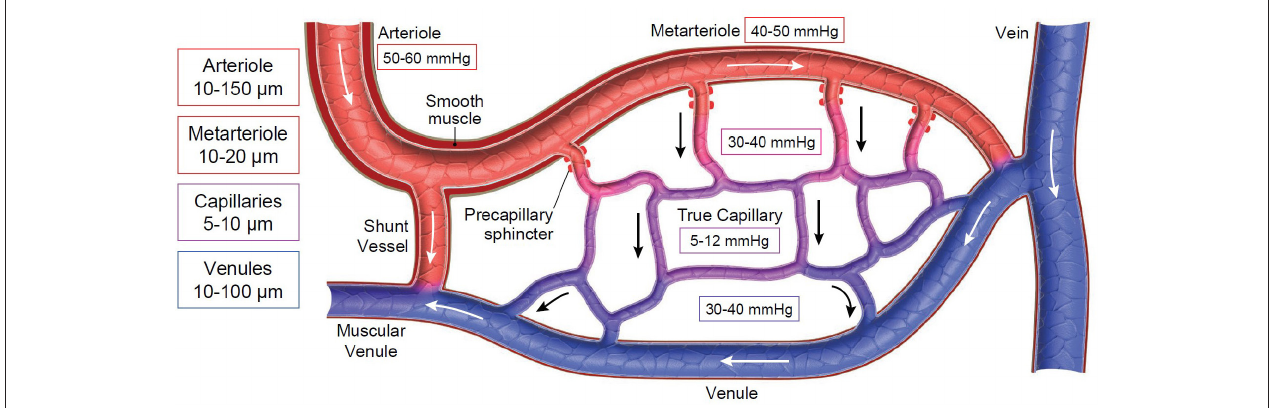
FIGURE 1 | Schematic of the microcirculation. Boxes on the left represent ranges of vessel diameters at varying levels of the microcirculation. Boxes throughout the diagram represent the average interstitial (tissue) oxygen tension (P t O 2 ). Arrows represent direction of blood flow across the microcirculatory unit.